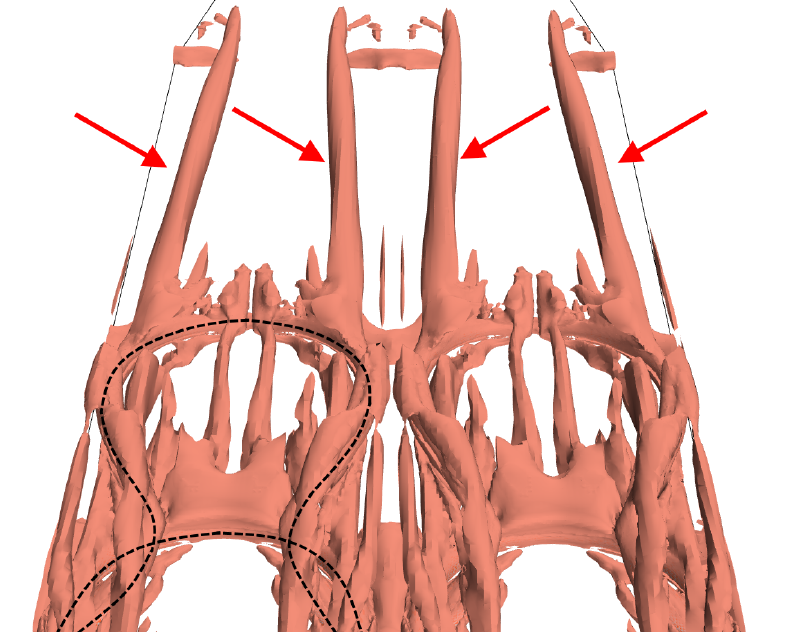
Figure 17. Isosurface of the Q-criterion around the knitted wire mesh. The red arrows mark the elongated streamwise vortex structures. The dashed lines indicate the knitted wires. The isovalue is set to 100,000 1/s 2 .